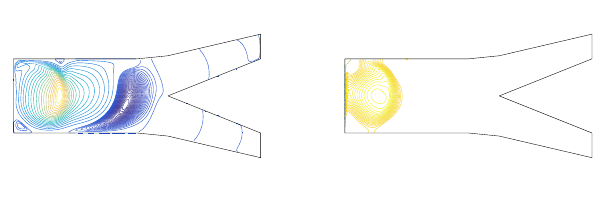
Figure 9. Computed streamlines(left) and pressure contours(right) for blood flow at ν = 0 .